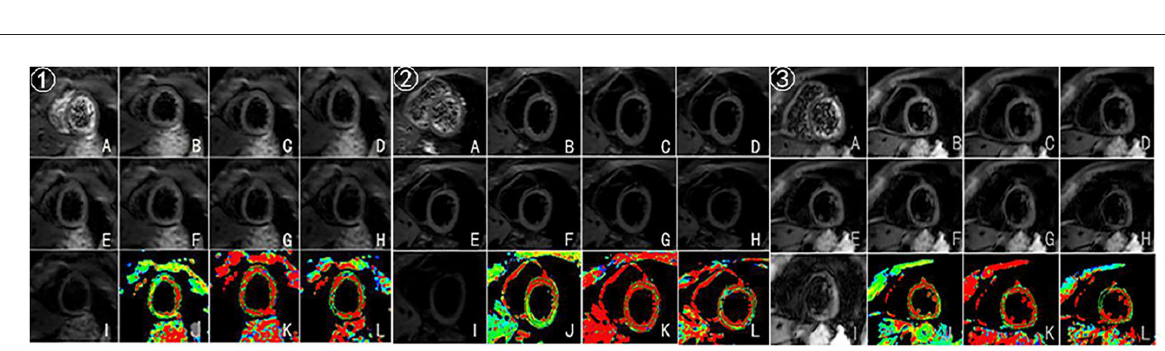
microcirculation perfusion. Further, Delattre et al. (11) and Mou et al. (12) applied it to the human body and proved that it was